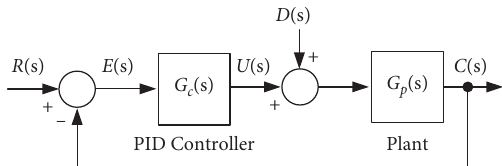
Figure 9: Operation diagram of the PI controller.